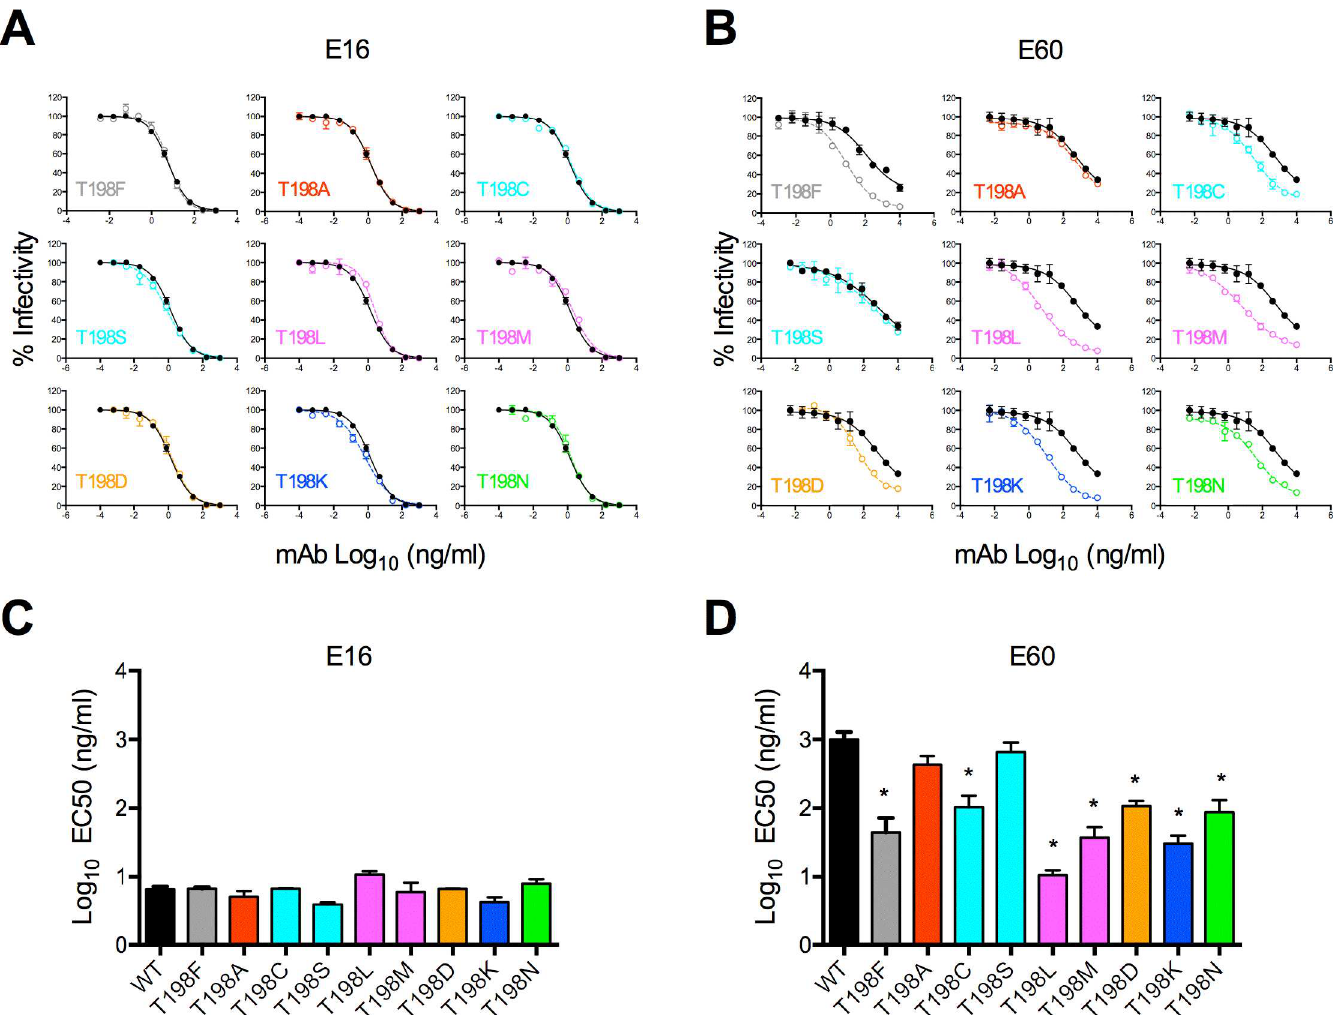
Fig 3. Effectof amino acid chemistryon neutralization sensitivityof WNV E T198 RVP variants. We tested WT WNV RVPs containing threonineat E residue198(black curves) for sensitivityto neutralization by mAbs (A) E16 and (B) E60 concurrently withRVPs incorporatingaminoacidvariantsrepresenting distinctchemicalgroupsat residue198, includingaromatic (F; grey), small(A; red), nucleophilic (C, S; cyan), hydrophobic(L, M; magenta), acidic(D; orange), basic(K; blue),andamide(N; green).Error bars indicatethe rangeof infectivityfrom duplicate infections.PercentinfectivityversusmAb concentration is shown in eachgraph.Infectivity was normalized to levelsobservedin the absenceof antibody.We compared the meanEC50valuesfor (C) E16 and (D) E60 against eachvariantto thoseof WT RVPs usinga one-wayANOVA followedby Dunnett’s multiplecomparisons test. Datawereobtainedfrom threeindependent experiments performed in duplicate. Error bars indicatethe SEM. The color schemefor distinct aminoacidchemical groupscorrespondsto that in (A) and (B) . * ,p < 0.05.